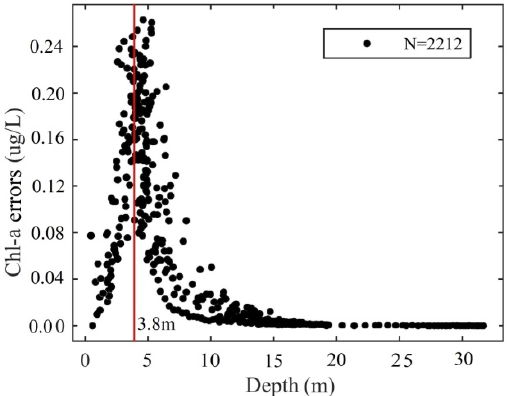
Figure 17. The errors caused by bottom reflectance against water depth ( H ).